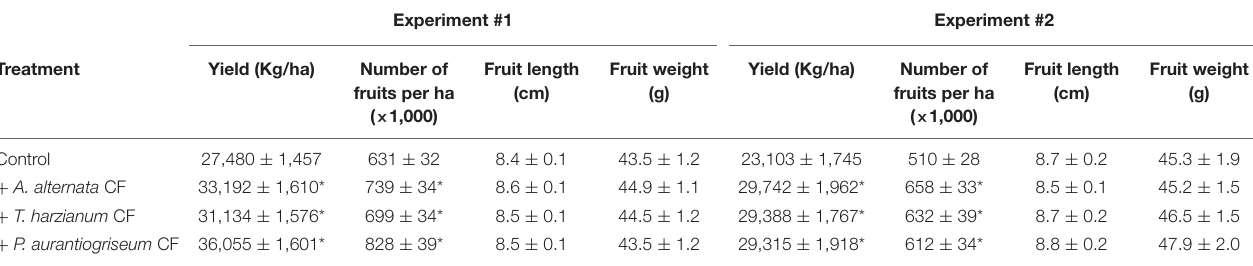
TABLE 3 | Soil application of A. alternata, P. aurantiogriseum , and T. harzianum CFs enhances commercial fruit number and yield of pepper plants (cv. Piquillo) cultured under open field